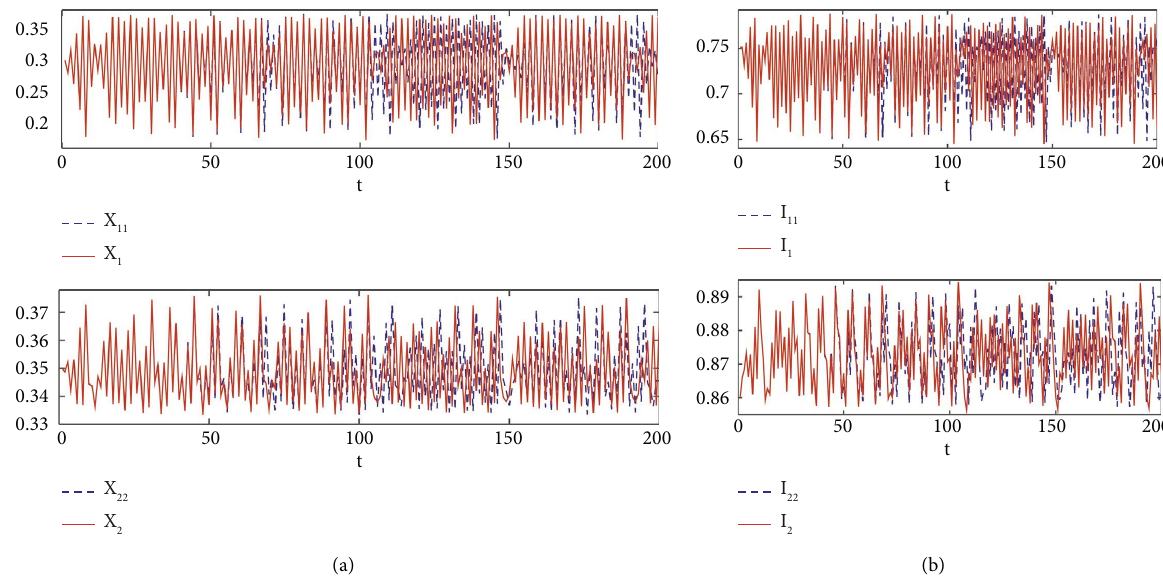
Figure 6: Te discrete dynamic system (8) sensitive dependence on the initial value after